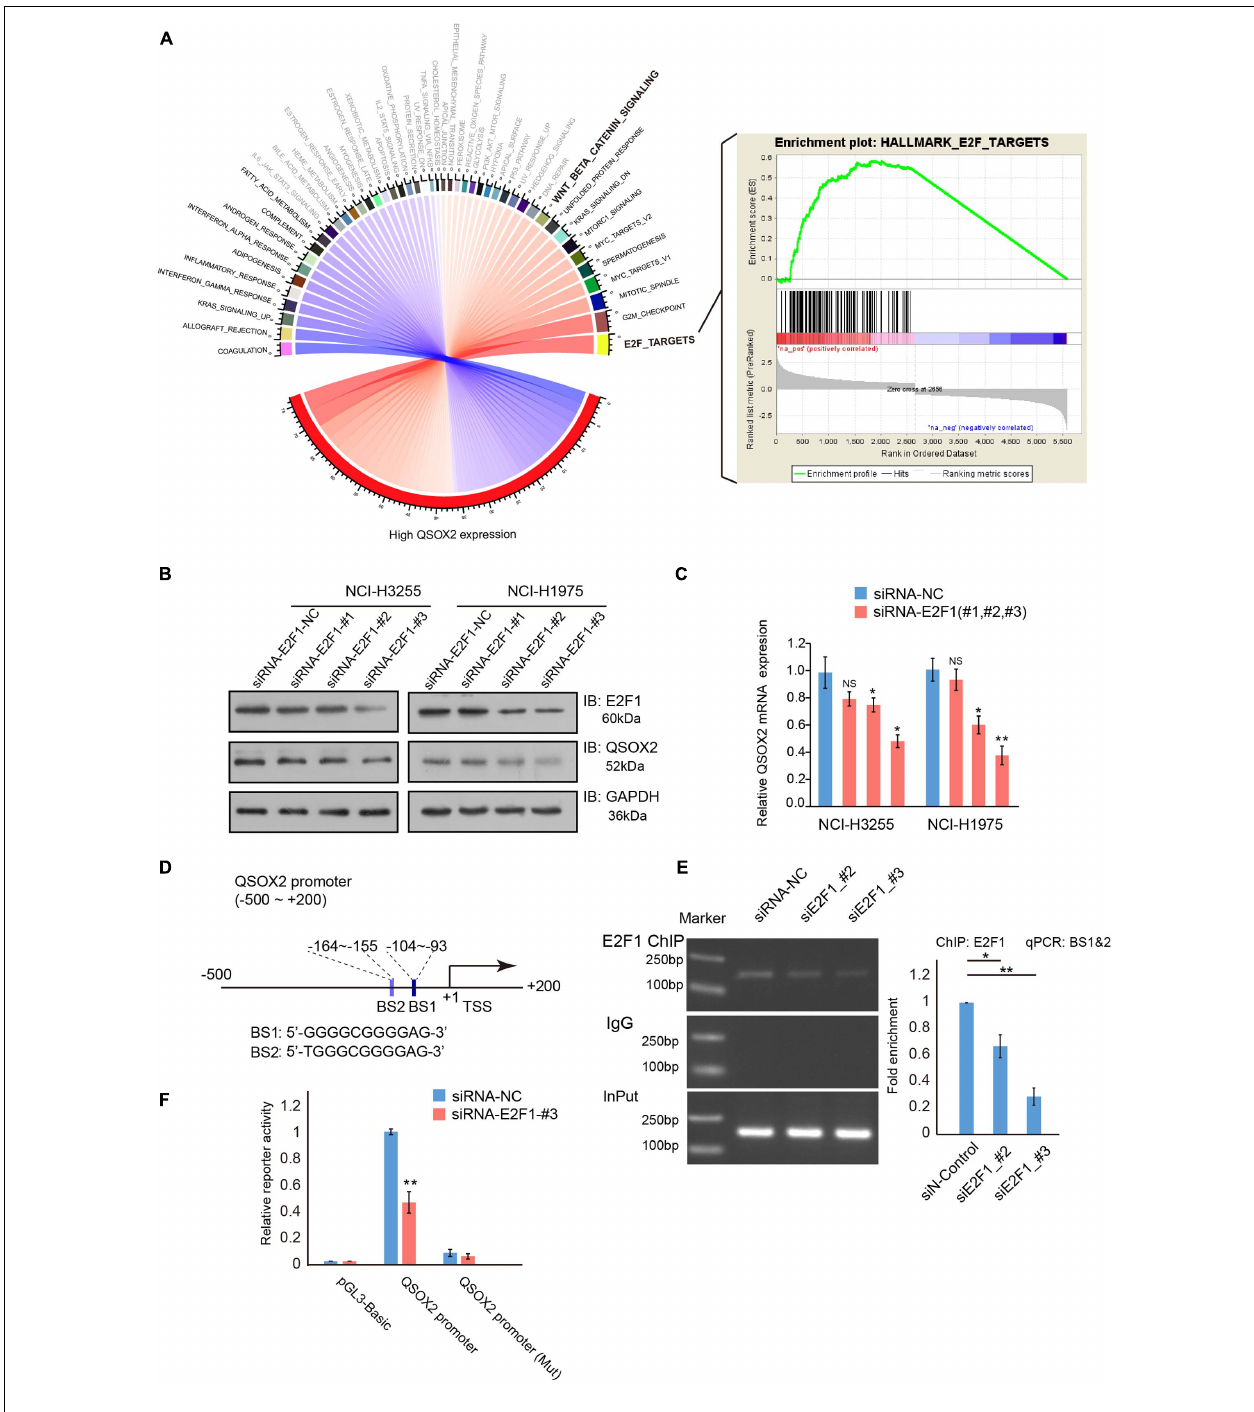
FIGURE 5 | E2F transcription factor 1 ( E2F1 ) regulates QSOX2 expression directly. (A) Chord diagram of all enriched hallmark gene sets in a GSEA. Black font: FDR < 0.05; Gray font: FDR ≥ 0.05; Blue curve: negative enrichment; Red curve: positive enrichment. (B) WB analysis of NCI-H3255 and NCI-H1975 cells transfected with shRNA-control or shRNA-E2F1 (48 h) and evaluated with the indicated antibodies. (C) NCI-H3255 and NCI-H1975 cells transfected with the indicated plasmids and subjected to real-time PCR analysis for E2F1 and QSOX2 expression. * P < 0.05, ** P < 0.01. (D) Schematic diagram of the putative bonding sites for E2F1 in the QSOX2 promoter region. BS1: binding site 1; BS2: binding site 2. (E) Chip-qPCR analysis of E2F1 binding to the promotor of QSOX2 in 293T cells after treatment with siRNA-NC or siRNAs-E2F1. Purified rabbit IgG was used as a negative control for the background enrichment signal; * P < 0.01; ** P < 0.001. (F) Co-transfection of the QSOX2 promoter and siRNAs-E2F1 into 293T cells in triplicate. Relative QSOX2 promoter activities were measured at 48 h after transfection by a dual-luciferase assay; * P < 0.05, ** P <